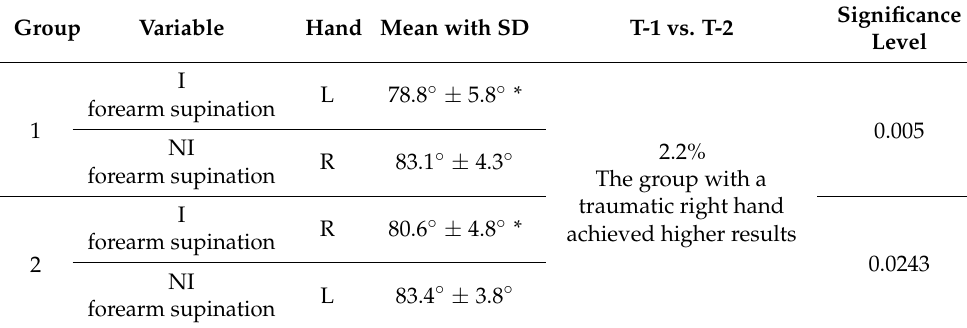
Table 7. Comparison of results for forearm